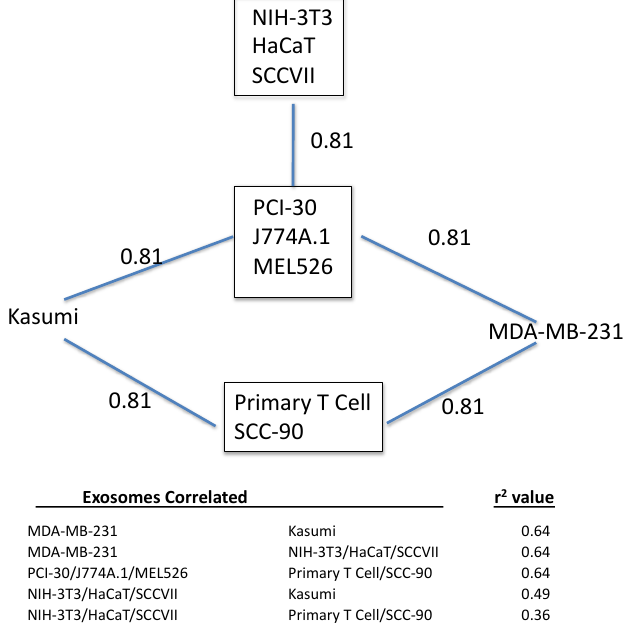
Figure 7. Path analysis for exosomes. Exosomes listed in boxes correlated perfectly (r 2 = 1.0) with other graphed relations found to be statistically significant. Values below the figure are remaining possible correlations and their r 2 values, none of which were significant.